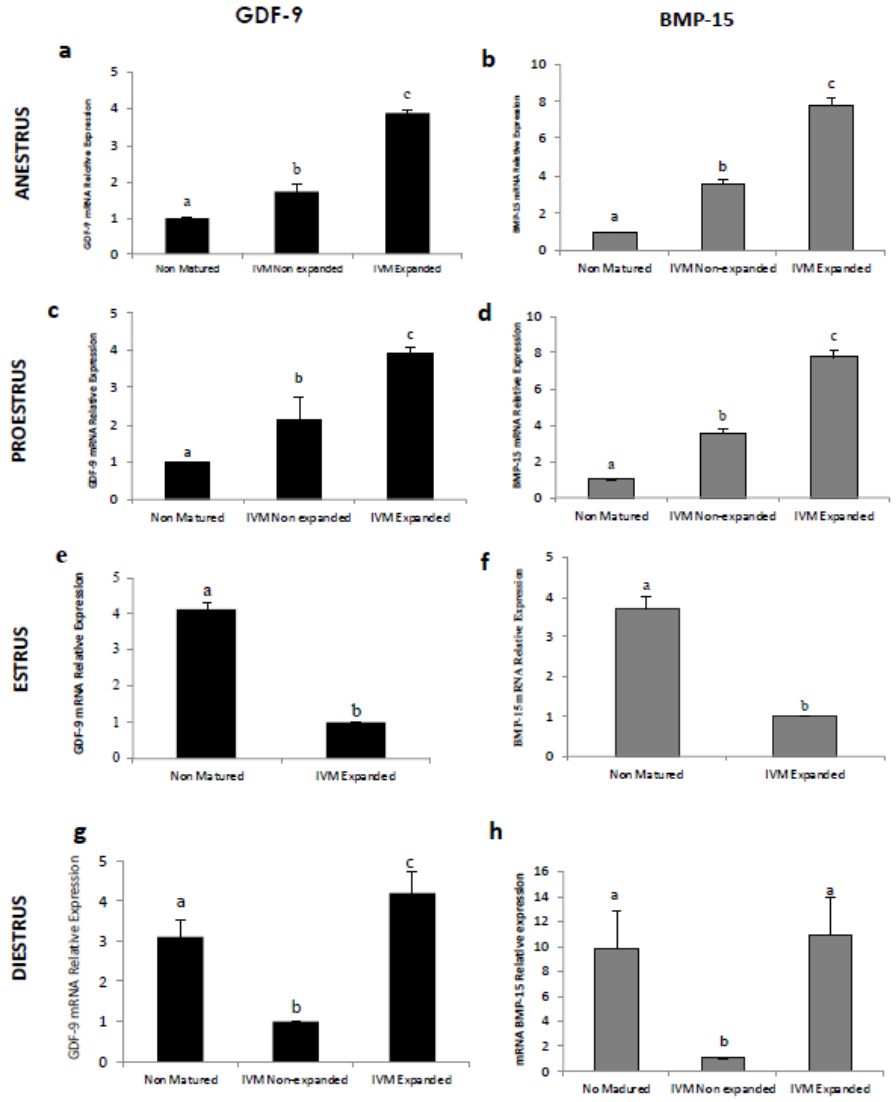
Figure 4. Relative gene expression of Growth Differentiation Factor 9 ( GDF-9 ) and Bone Morphogenetic Protein 15 ( BMP-15 ) in canine cumulus cells according to the maturation and expansion of the cumulus cells at anestrus ( a,b ), proestrus ( c,d ), estrus ( e,f ), and diestrus ( g,h ). The GDF-9 and BMP-15 mRNA levels were expressed in relation to β-Actin mRNA as the control or housekeeping gene. For each gene ( GDF-9 or BMP-15 ), bars with different superscripts show a significant difference at p < 0.05.